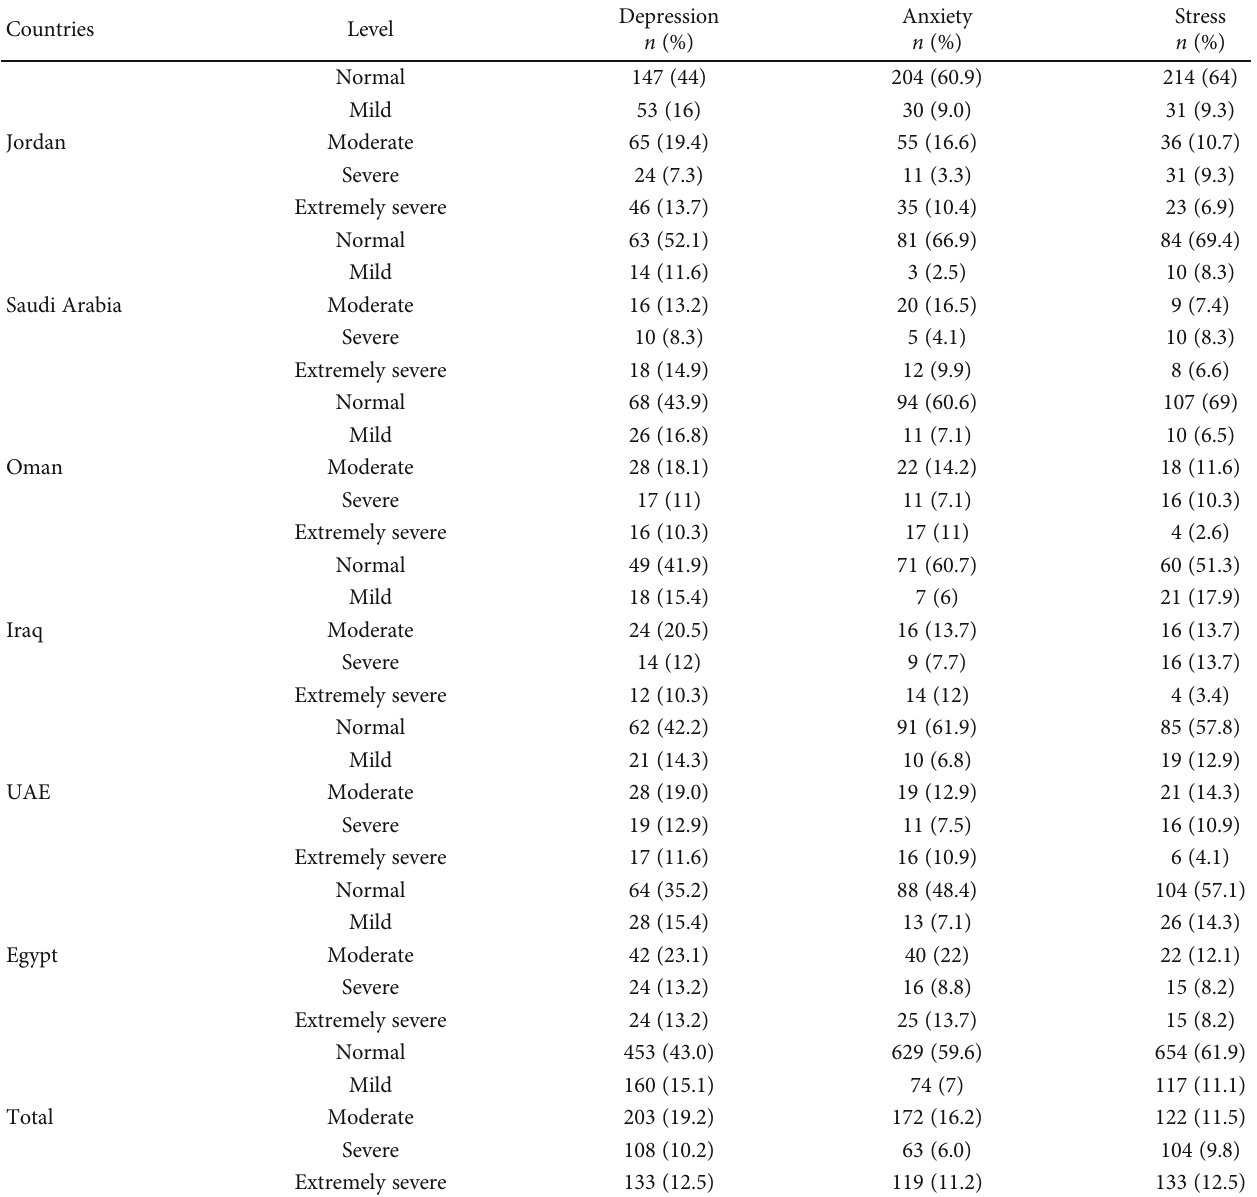
Table 2: Prevalence of depression, anxiety, and stress ( N = 1,057